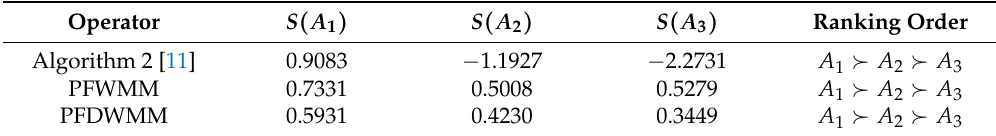
Table 11. The ranking index and ranking results of three R&D